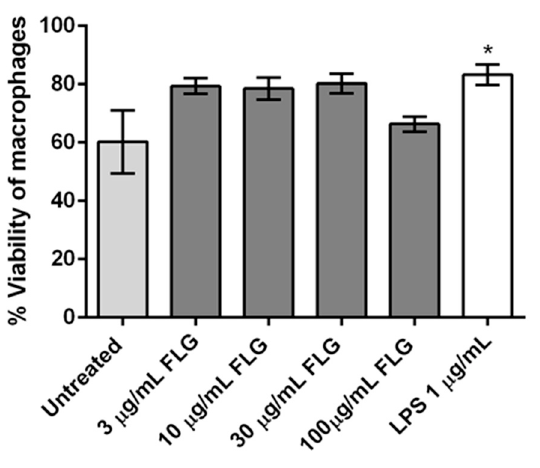
Figure 3. Flow cytometry analysis of cellular viability of BMDMs treated with different concentrations of FLG (3, 10, 30 and 100 µg/mL), with LPS (1 µg/mL) and left untreated, for 24 h. One-way ANOVA followed by Bonferroni’s test was performed to determine the statistical differences among samples versus control untreated cells (* p < 0.05).